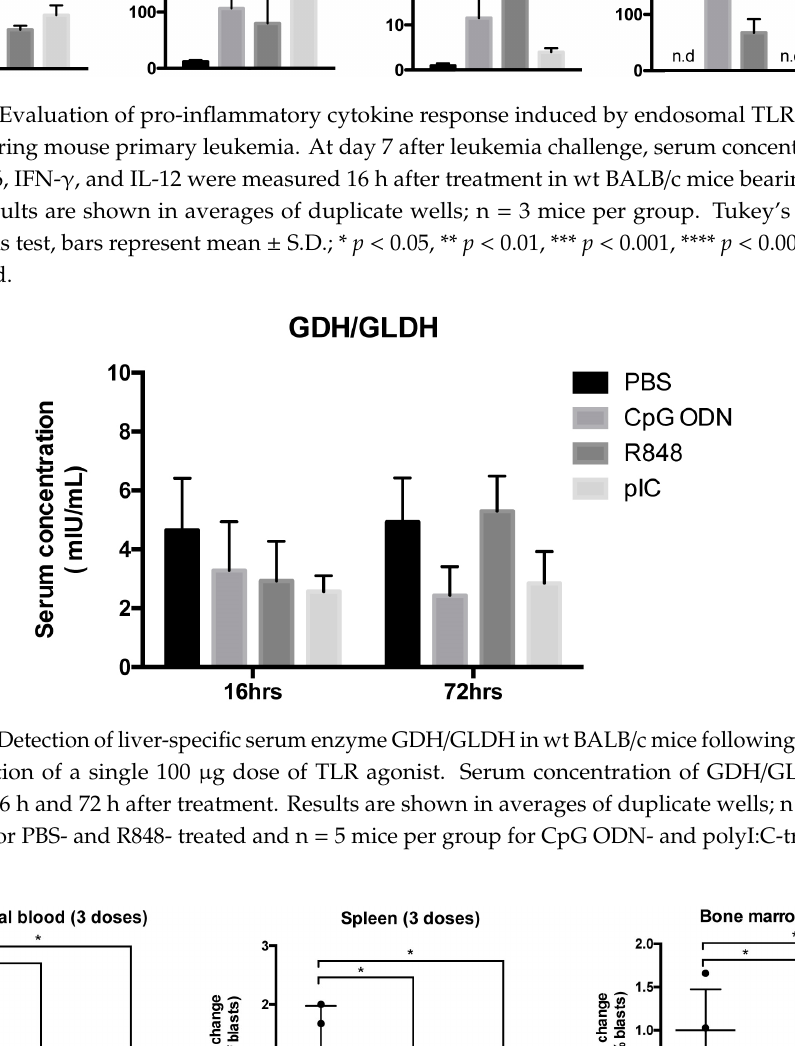
in mice bearing mouse primary leukemia. At day 7 after leukemia challenge, serum concentration of